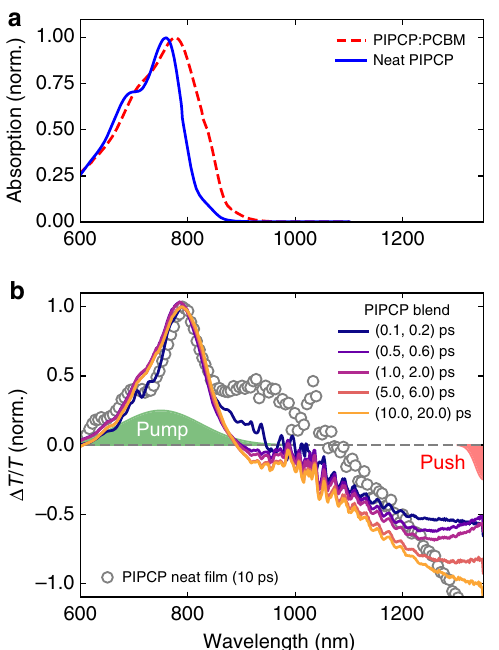
Fig. 2 Transient optical absorption of PIPCP:PCBM. a Steady-state absorption for neat PIPCP and PIPCP:PCBM blend. b PP transient absorption spectra of the PIPCP:PCBM blend at selected pump-probe delays. The TA spectrum of neat PIPCP at 10 ps is shown in grey circles for comparison. Spectra were recorded at an excitation fl uence of 50 μ J cm − 2 . Noted are the approximate spectra for the pump and push pulses. Non- normalised data can be found in the Supplementary Fig. 1